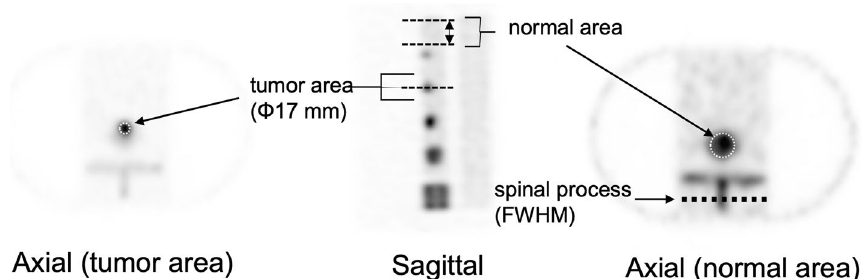
Fig. 2 Settings of the region of interest for evaluating image